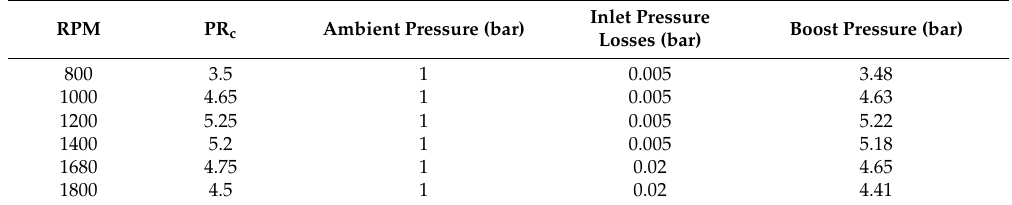
Figure 8. In-Cylinder Maximum Temperature and Pressure, comparison between RM and MC 6. Table 7. Boost pressure required from the turbocharger to produce the PR c that the MC 6 diesel engine requires to deliver the outcomes stated in this